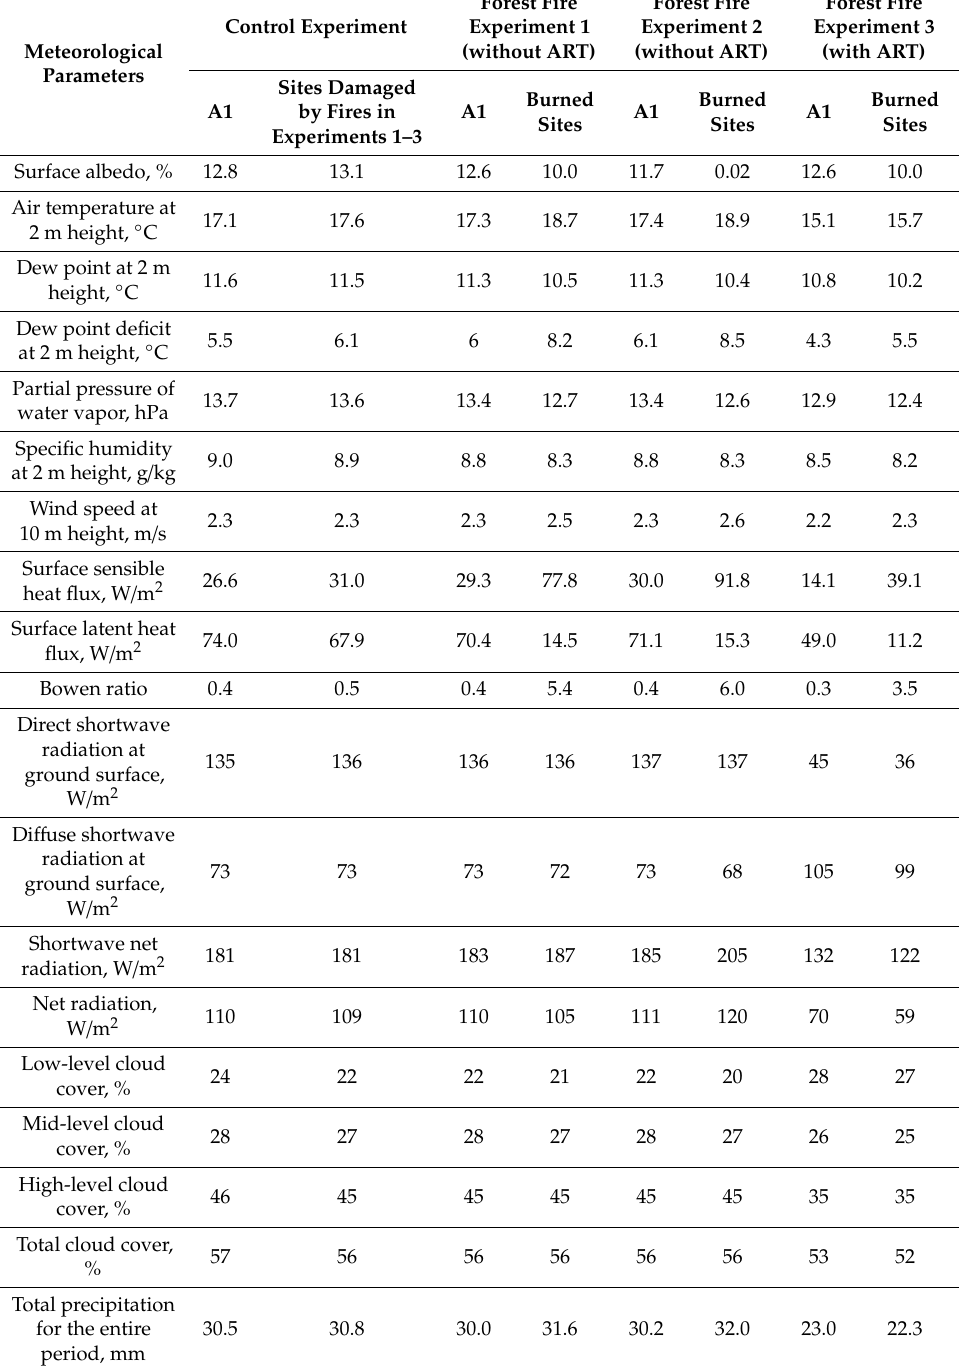
Table 1. Mean values of meteorological parameters for the entire Area 1 (A1) and burned sites within the Area 1 (Figure 1) from 1 to 14 August 2019 derived from forest fire